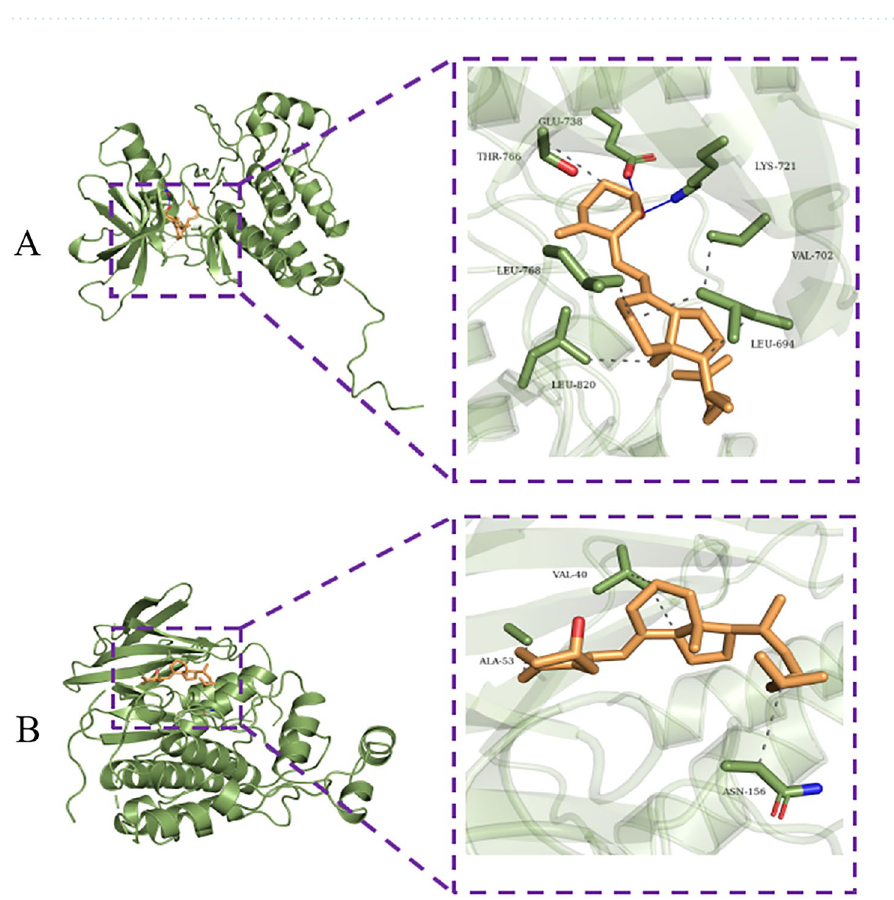
Figure 10. Docking pattern diagram of VitD with EGFR ( A ) and MAPK8 ( B ) The molecular docking pattern plots for VitD with EGFR ( A ) and MAPK8 ( B ),